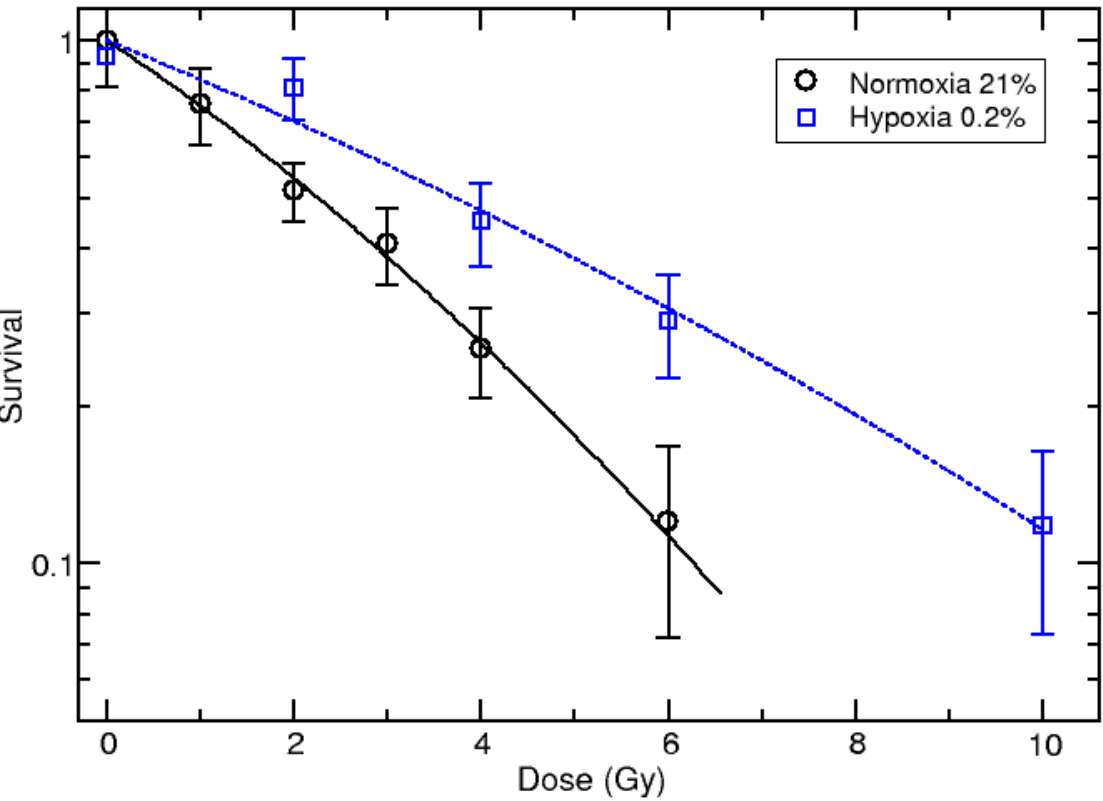
Figure 1. Survival curve of U87 cells irradiated in normoxia (O 2 = 21%) from updated data [9] and hypoxia (O 2 = 0.2%) with 62 MeV proton beam. The measured values are shown with black circles (normoxia) and blue squares (hypoxia), and the lines correspond to the linear–quadratic fit of measured data.